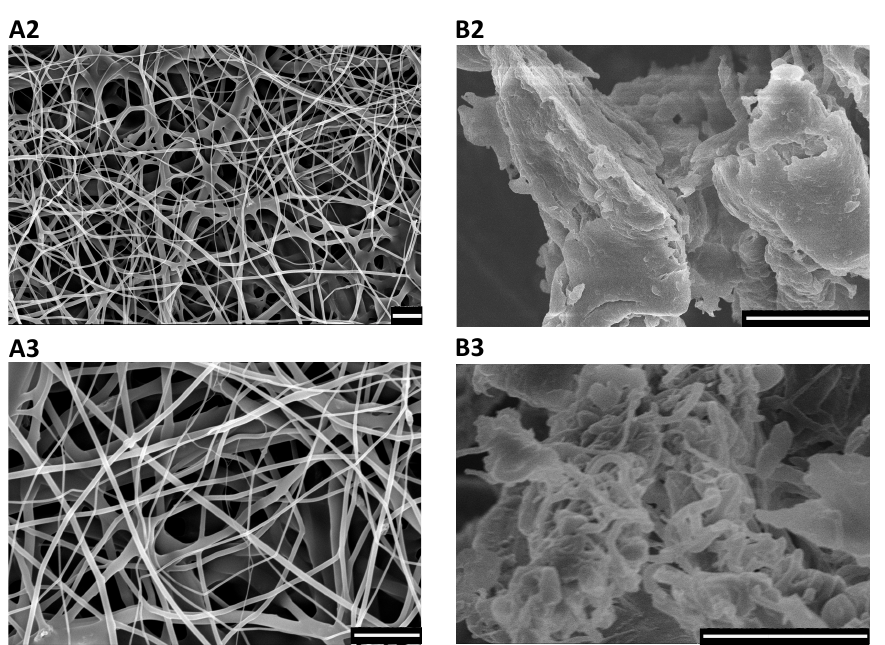
Figure 3. SEM images and diameter distributions of nanofibrous samples produced by nozzle-free electrospinning. The scale bar is 10 µm on every microscopic image. ( A1 ) In the case of the nanofibers containing 5 w% ciprofloxacin (NF-5), the free-surface electrospinning was successful. The average fiber diameter was 1167 ± 415 nm, but the size distribution was polydisperse and strongly skewed left. ( A2 , A3 ) The fibers were mainly individual and had smooth surfaces. ( B2 , B3 ) The nozzle-free electrospinning of 10 w% ciprofloxacin containing nanofibers (NF-10) was impractical; instead of separated fibers, merged fiber balls and polymer films were prepared. ( B1 ) Thus, the fiber size was not measurable and the distribution was not interpretable.